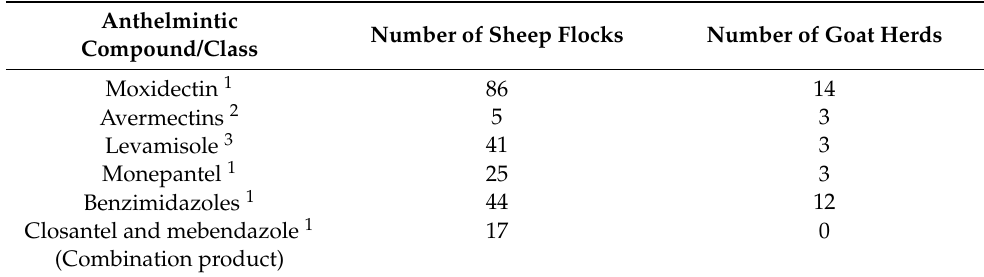
Table 1. Anthelmintics used by farmers and their veterinarians in 223 small ruminant flocks which fulfilled the inclusion criteria for post-treatment assessment of treatment effectiveness, specifying the number of sheep flocks/goat herds in each anthelmintic category. Some farmers used different anthelmintics in different animal groups, a total of 253 treatments were thus